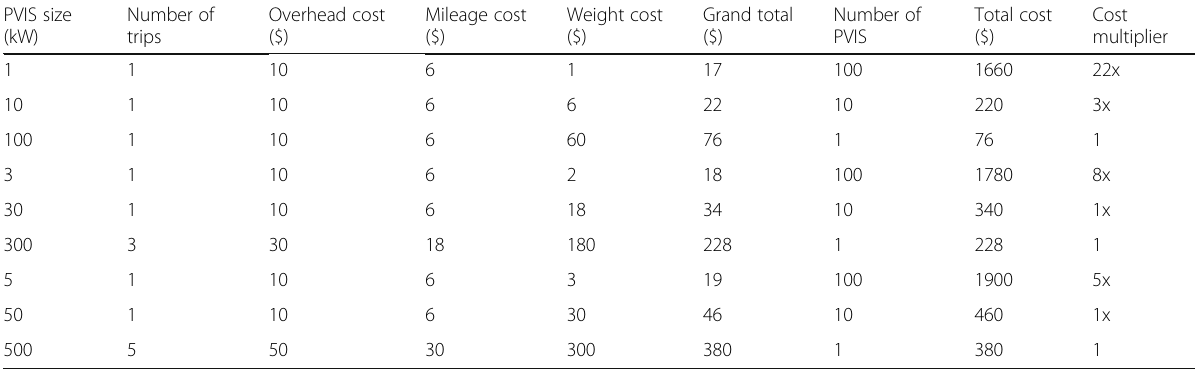
Table 1 Total cost and multiple of cost of PVIS size and number of PVIS combination PVIS size